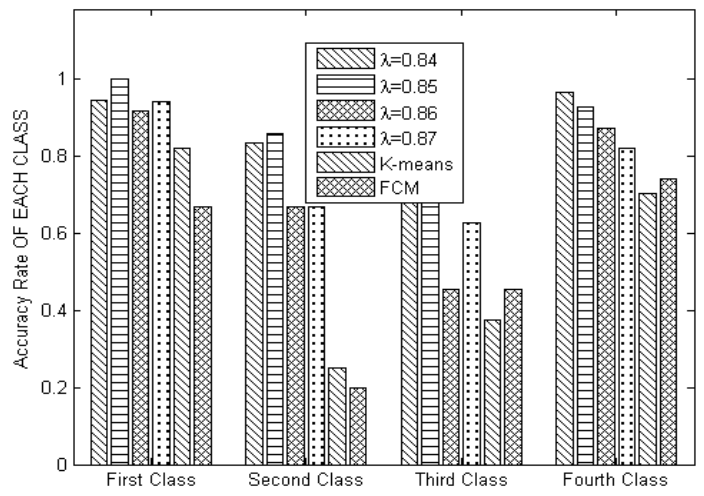
Figure 6. Comparison of accuracy rate of each class among GMRC, K-means and FCM algorithms.